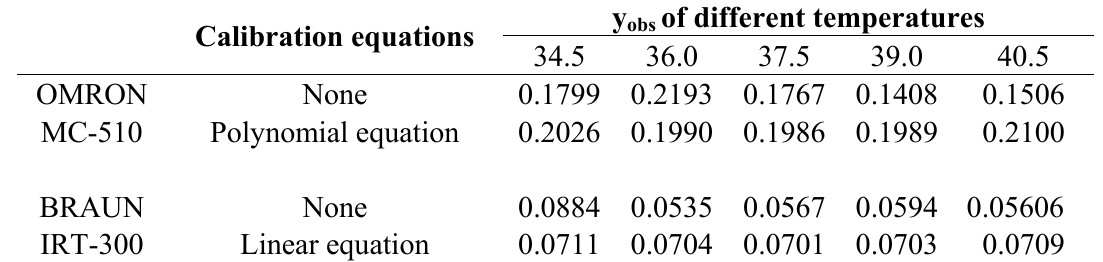
Table 4. The type A uncertainty of several observations for two infrared tympanic